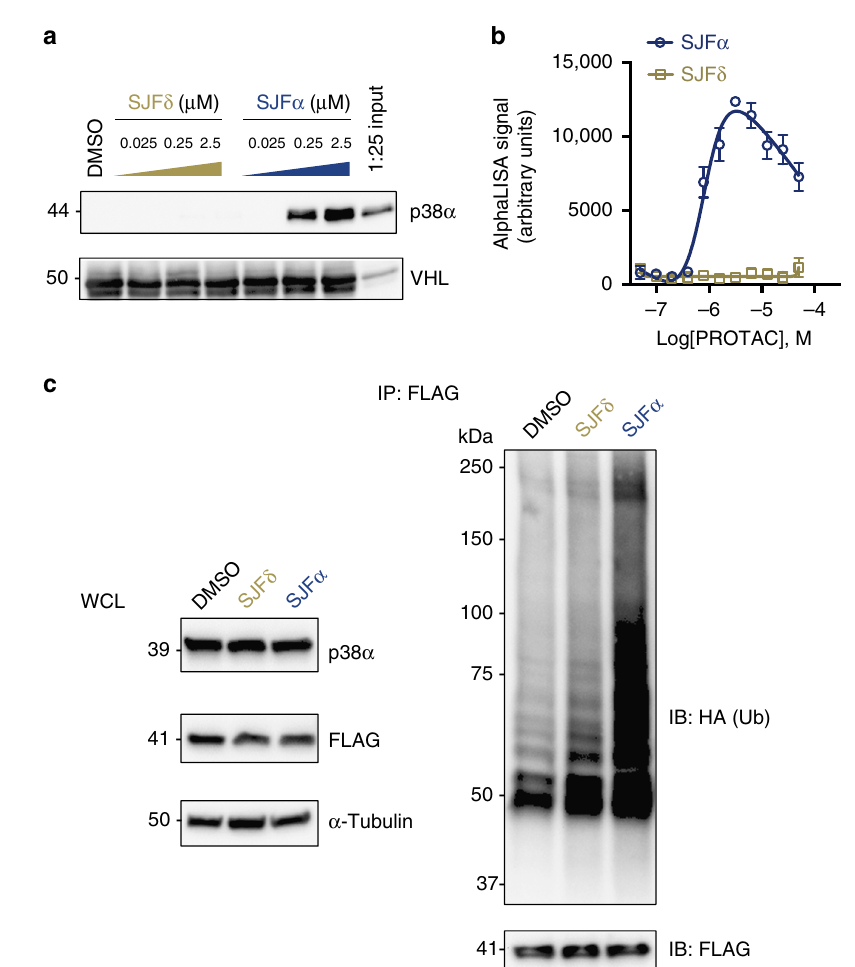
Fig. 3 p38 α selectivity is discriminated by ternary complex formation. a Only p38 α incubated in the presence of SJF α can be immunoprecipitated with GST- tagged VHL/EloB/EloC (VBC). Immobilized VBC was used as a “ bait ” to trap puri fi ed p38 α in the presence of vehicle (DMSO), SJF α , or SJF δ (represented in micromolar concentrations). The rightmost lane represents a 1:25 dilution of initial input protein used in each pull-down. b Proximity-based AlphaLISA assay detects signi fi cant p38 α :SJF α :VHL ternary complex, but no p38 α :SJF δ :VHL ternary complex. His-p38 α and GST-VBC were incubated in the presence of increasing concentrations of SJF α and SJF δ and the extent of ternary complex formation was assessed by excitation with incident light with λ = 680 nm and capture of the emission light at λ = 615 nm. Error bars represent the s.d from quadruplicate experiments. c Only SJF α ubiquitinates FLAG-p38 α in HeLa cells. HeLa cells co-transfected with HA-Ubiquitin (HA-Ub) and FLAG-p38 α were subsequently treated with either vehicle (DMSO), 500 nM SJF α , or 500 nM SJF δ for 1 h. FLAG-immunoprecipitated lysates were separated by sodium dodecyl sulfate polyacrylamide gel electrophoresis (SDS-PAGE) and assessed via western blots detecting HA (Ub). Smears represent ubiquitin-conjugated FLAG-p38 α and numerical markers to the left of the western blot refer to kilodalton (kDa) masses. WCL refers to “ whole-cell lysate ”